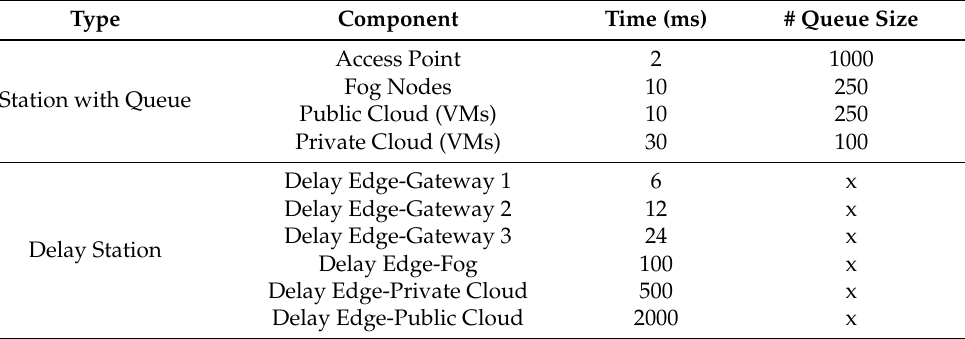
Table 4. Fixed input parameters used to feed the model.